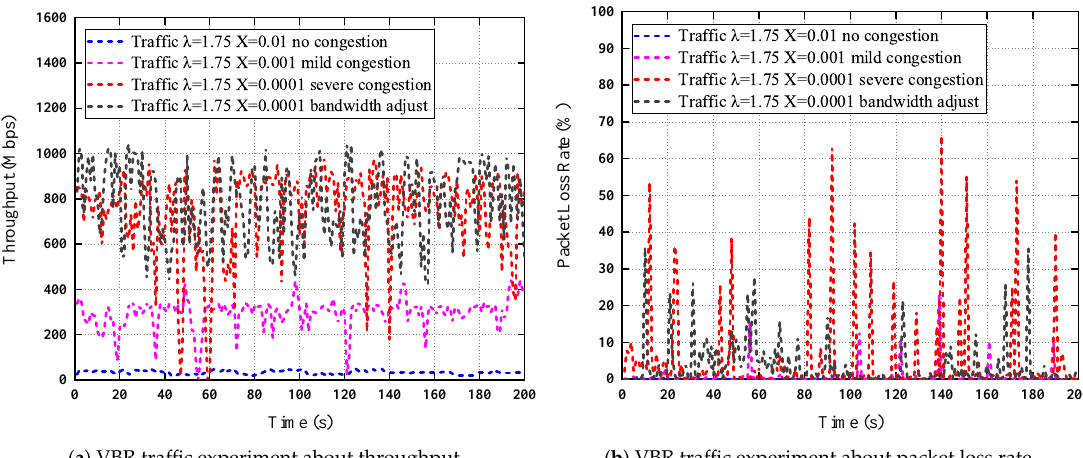
Figure 14. VBR traffic experiments over the Mininet